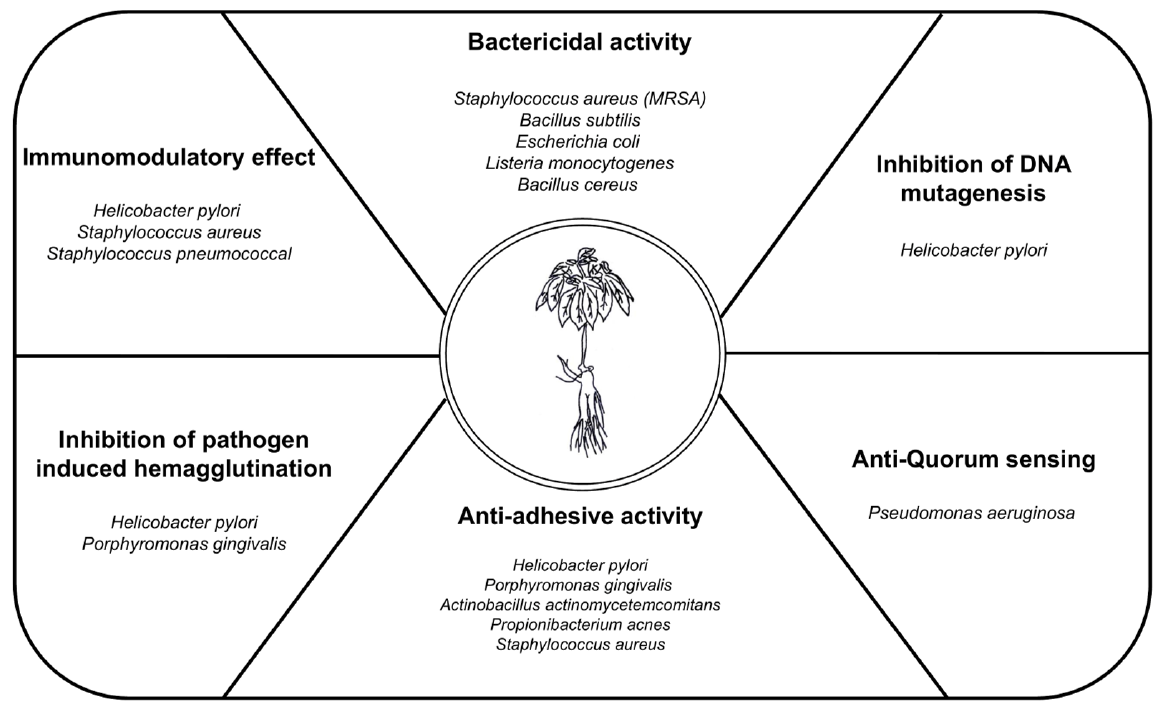
Figure 2: The main types of antibacterial activities of Panax ginseng. P. ginseng shows various antibacterial activities against infectious agents. P. ginseng convers antimicrobial therapy via various mechanisms, including bactericidal activity, immunomodulatory effects, inhi- bition of pathogen–induced hemagglutination, anti-adhesive activity, and anti-quorum sensing